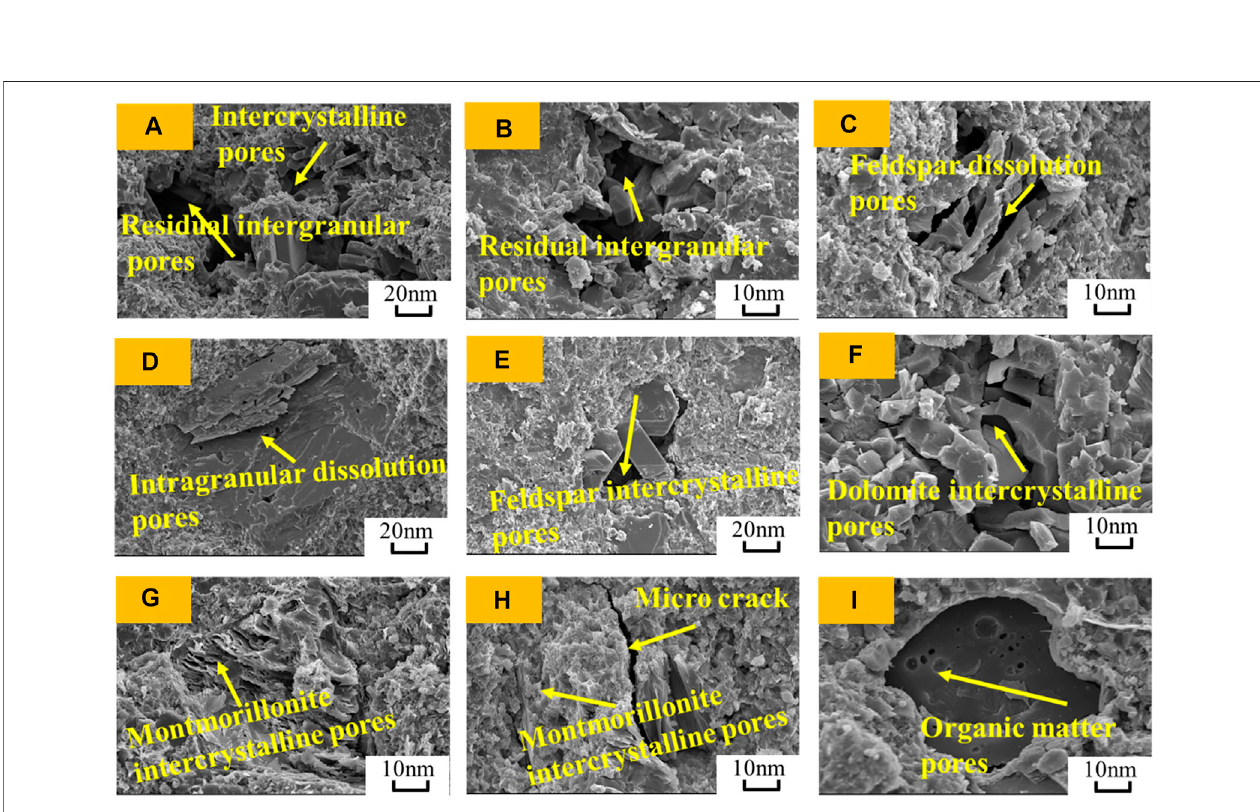
FIGURE 8 | SEM Pore Type Diagram. (A) Inter-crystalline pore and residual intergranular pore; (B) residual intergranular pore; (C) Feldspar dissolution pores; (D) Intragranular dissolution pores; (E) Feldspar intergranular pore; (F) Dolomite inter-crystalline pores; (G) Montmorillonite inter-crystalline pores; (H) Microcrack and montmorillonite inter-crystalline pores; and (I) organic matter pores.